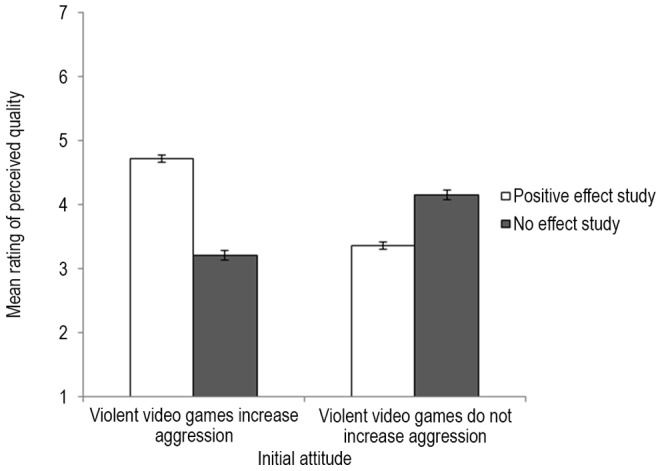
Mean ratings of perceived quality as a function of initial attitude and study effect.Error bars depict two standard errors.